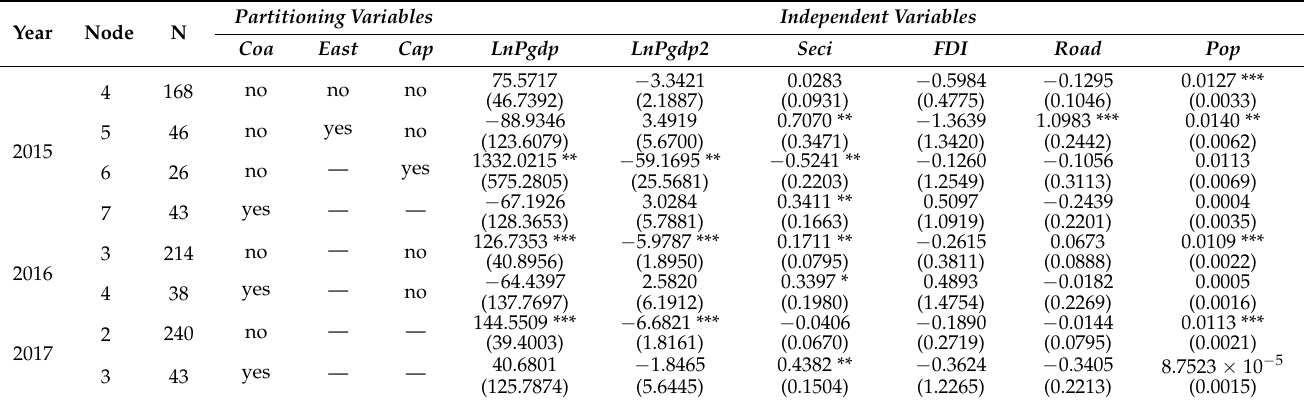
Table A6. Results of a recursive analysis of air pollution influences under the K-neighbor SWM (K = 4) for the period